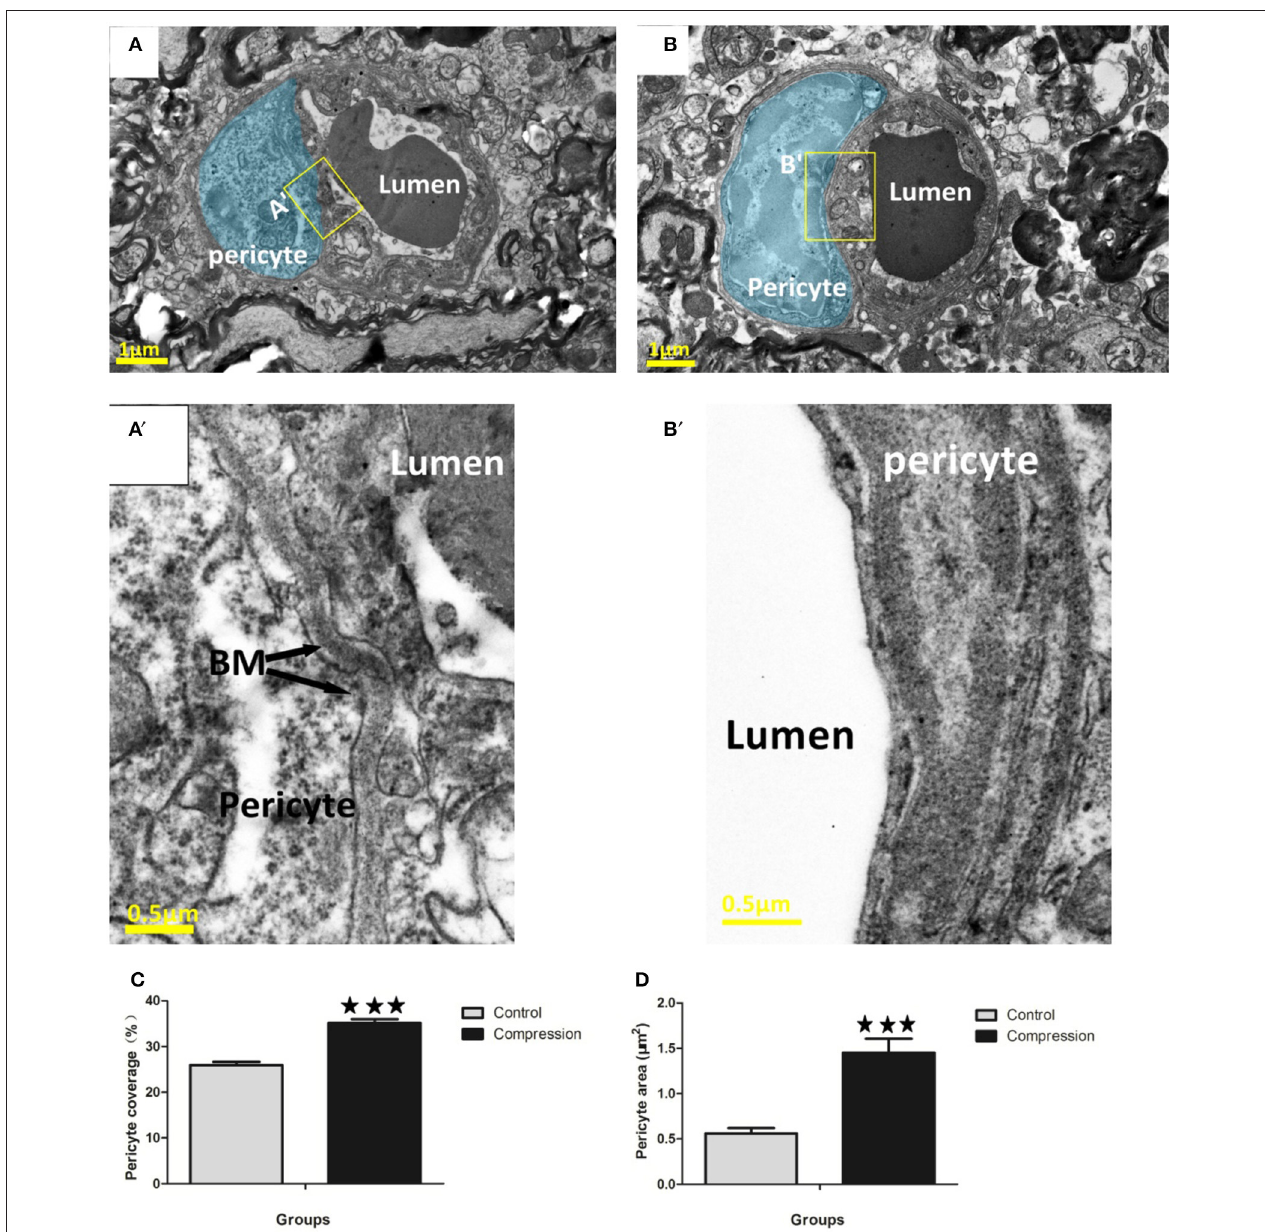
FIGURE 6 | EMs of microvessels in the control group (A,A ′ ) , and corrugated BM (A ′ ) . Pericytes are highlighted in blue (A,B) . Pericyte processes appeared slightly swollen (B,B ′ ) , and smooth BM were detected in the compression group. Quantitative analysis indicated that pericyte coverage of the endothelium (C) and cross-sectional area (D) increased significantly in the compression group. The number of capillaries analyzed per group was 30, sampled from 12 rats per group. *** P < 0.001 relative to controls.